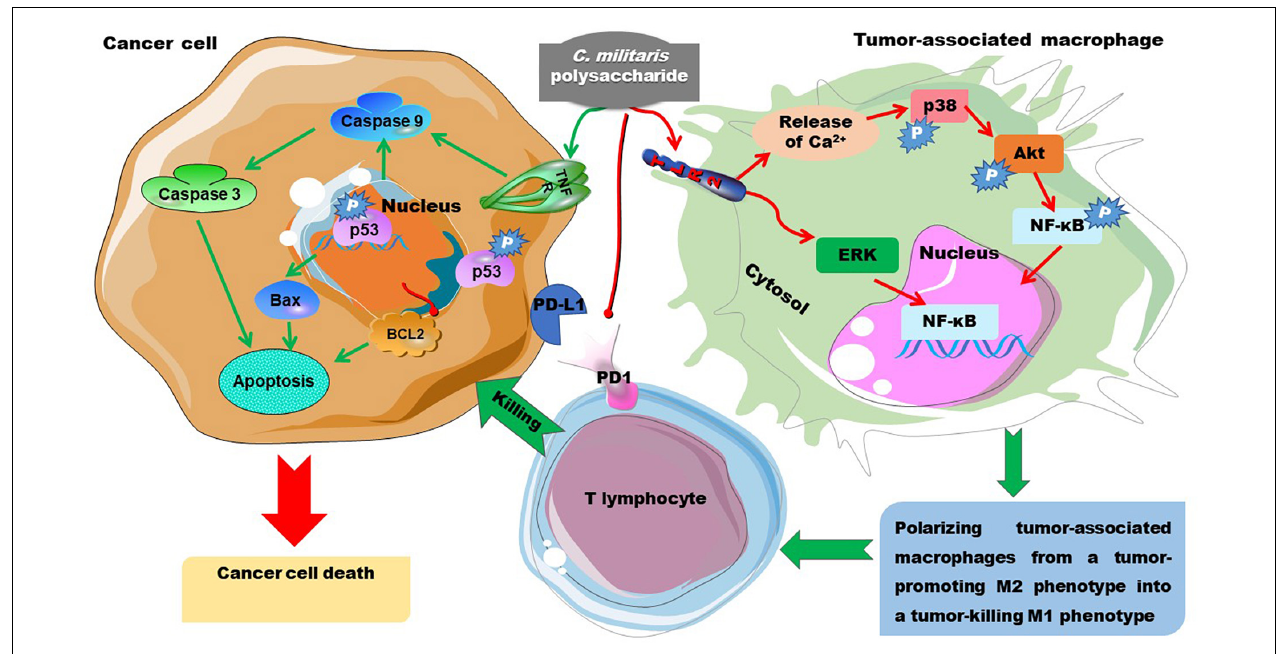
FIGURE 10 | The anti-tumor mechanisms of C. militaris -derived polysaccharides. C. militaris -derived polysaccharides induce cancer cell death by enhancing apoptosis-associated signaling. Alternatively, they polarize tumor-associated macrophages from M2 to M1 phenotype, thereby promoting the cancer cell killing activity of T lymphocytes. AKT/PKB, phosphoinositide-3-kinase/protein kinase B; Bax, B cell leukemia/lymphoma 2-associated X protein; Bcl-2, B cell leukemia/lymphoma 2; ERK, extracellular regulated kinase; NF- κ B, nuclear factor kappa-B; PD-1, programmed death-1; PD-L1, programmed death lignd-1.